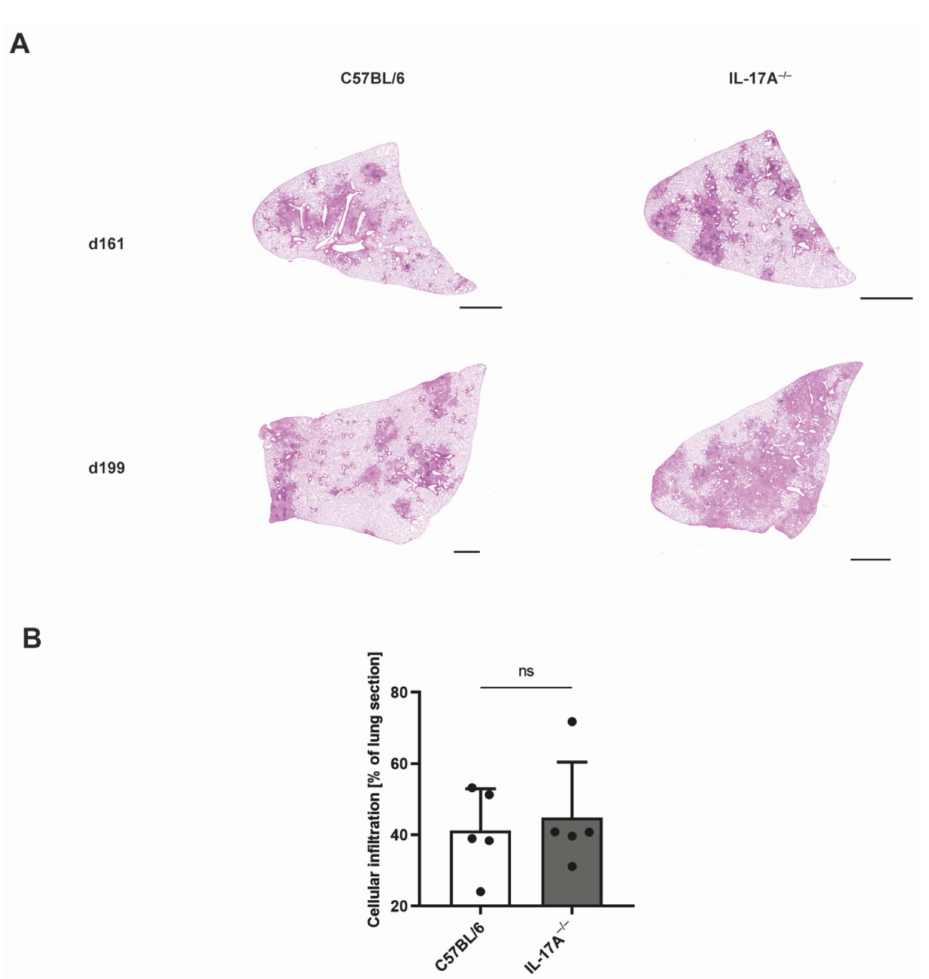
Figure 2. After infection with an elevated dose of Mtb, the lungs of IL-17A − / − mice show similar inflammatory cellular infiltrates. C57BL/6 and IL-17A − / − mice were infected with 100–1000 CFU of H37rv Mtb by an aerosol. Formalin-fixed lung sections taken on Days 161 and 199 post-infection were stained with H&E. ( A ) Representative lung sections from 1 out of 5 mice per group are shown (magnification: 40 × , bar: 2 mm). ( B ) Proportions of cellular infiltration within the total area of the lung sections taken on Day 199 post-infection were determined in 4–8 serial sections per animal. Data are presented as single dots and as the mean ± SD of 5 mice per group from one representative experiment. Statistical analyses were conducted using a Mann-Whitney test. Differences in the survival kinetics between C57BL/6 and IL-17A − / − mice were defined as significant (ns p ≥